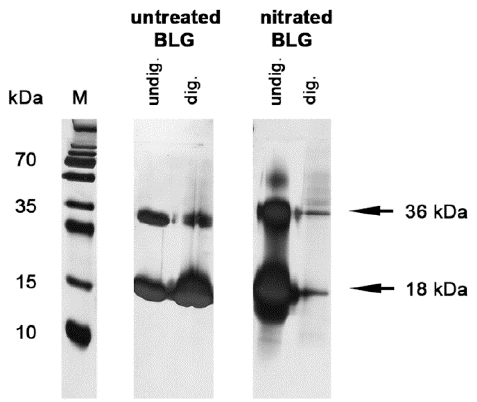
Figure 2. Nitration decreases gastric stability. BLGu ( left panel ) and BLGn ( right panel ) were subjected to gastric digestion for 120 min, and the remaining fragments were visualized in SDS-PAGE. The presence of nitrated tyrosine residues in BLG was discovered to accelerate degradation compared to untreated controls. BLG, beta-lactoglobulin; BLGn, nitrated BLG; BLGu, untreated BLG; M, marker lane.